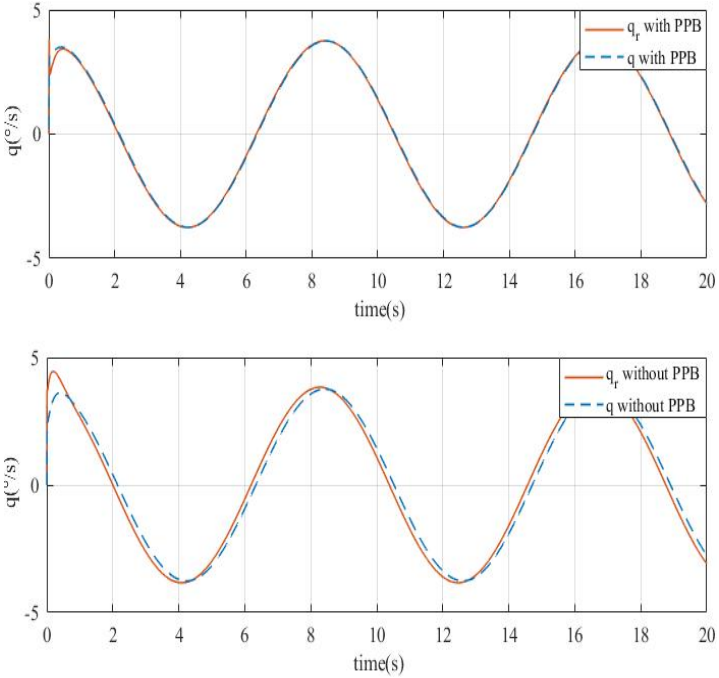
Figure 8. Tracking response of q .